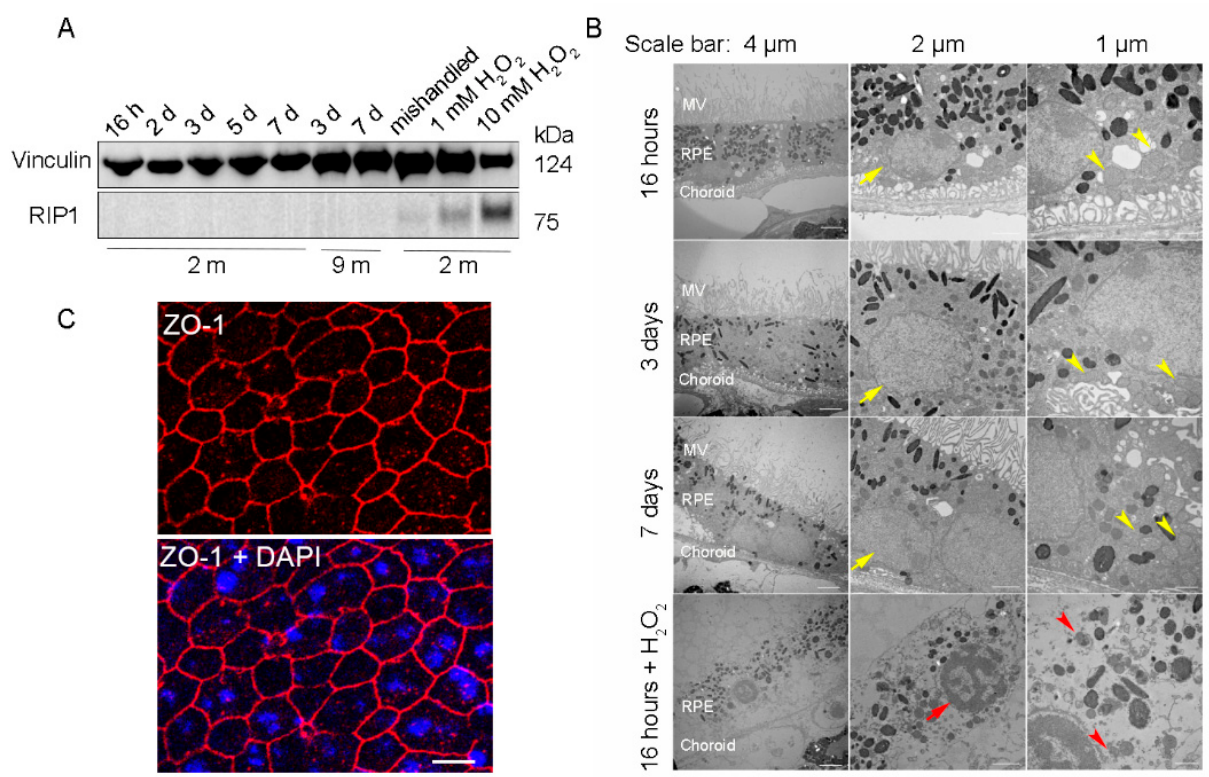
Figure 2. RPE flatmounts are viable for at least one week after culture in vitro . ( A ) RPE flatmounts were prepared from 2- and 9-month-old wild-type C57BL/6J mice and cultured in complete medium with or without H 2 O 2 for up to one week. Protein lysates were prepared from the RPE flatmounts and subjected to Western blotting analysis. The cell death marker RIP1 was used to evaluate cell viability; vinculin was used as an internal control. As a positive control: RPE flatmounts treated with either 1 mM or 10 mM H 2 O 2 had significant expression of RIP1. Further, the RPE flatmount that was cultured for 7 days without changing the medium (mishandled sample) showed a slight amount of RIP1, whereas the RPE flatmounts cultured with frequent medium changes did not express RIP1, suggesting that the RPE cells obtained even from older mice (9 months) were viable after at least 7 days of culture. ( B ) RPE flatmounts were obtained from 3-month-old wild-type C57BL/6J mice and cultured in complete medium with or without H 2 O 2 treatment for up to one week. RPE flatmounts were then fixed in 2.5% glutaraldehyde and processed for transmission electron microscopy (TEM). The TEM imaging of the RPE flatmounts cultured for 16 h, 3 days, and 7 days showed that these RPE cells have normal nuclei (yellow arrows) and organelles, such as mitochondria (yellow arrowheads), and abundant microvilli. H 2 O 2 -treated RPE flatmounts showed cell death symptoms, including chromatin condensation and fragmentation (red arrow), a disrupted cell membrane, complete loss of microvilli, a translucent cytoplasm, and severely damaged mitochondria (red arrowheads). ( C ) ZO-1 immunostaining on 2-month-old RPE flatmounts cultured for 3 days showed robust ZO-1 expression, indicating RPE cell